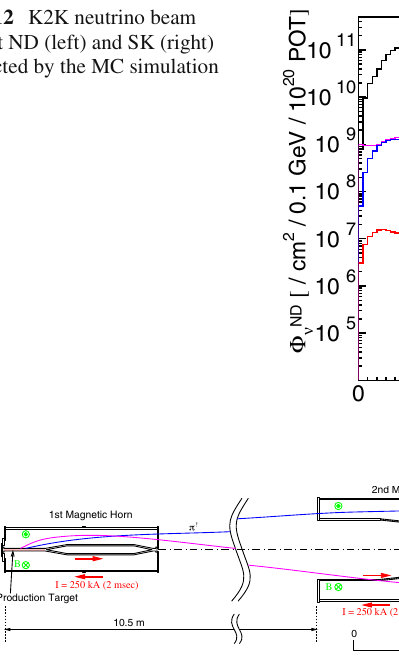
Fig. 13 Schematic view of the two horn magnets. An electrical current of 250 kA is supplied to both horns, creating a toroidal magnetic field inside the horns. The production target, an aluminum rod of 66 cm in length and 3 cm in diameter is embedded inside the first horn magnet, which also plays the role of the inner conductor of the horn. The second horn is located 10.5 m downstream of the first horn